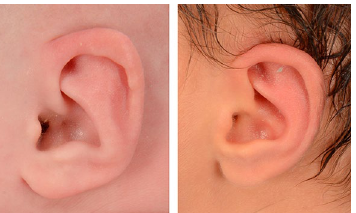
Figure 1. Post therapy outcome of two ears rated 3 (left) and 5 (right) by all PAs.